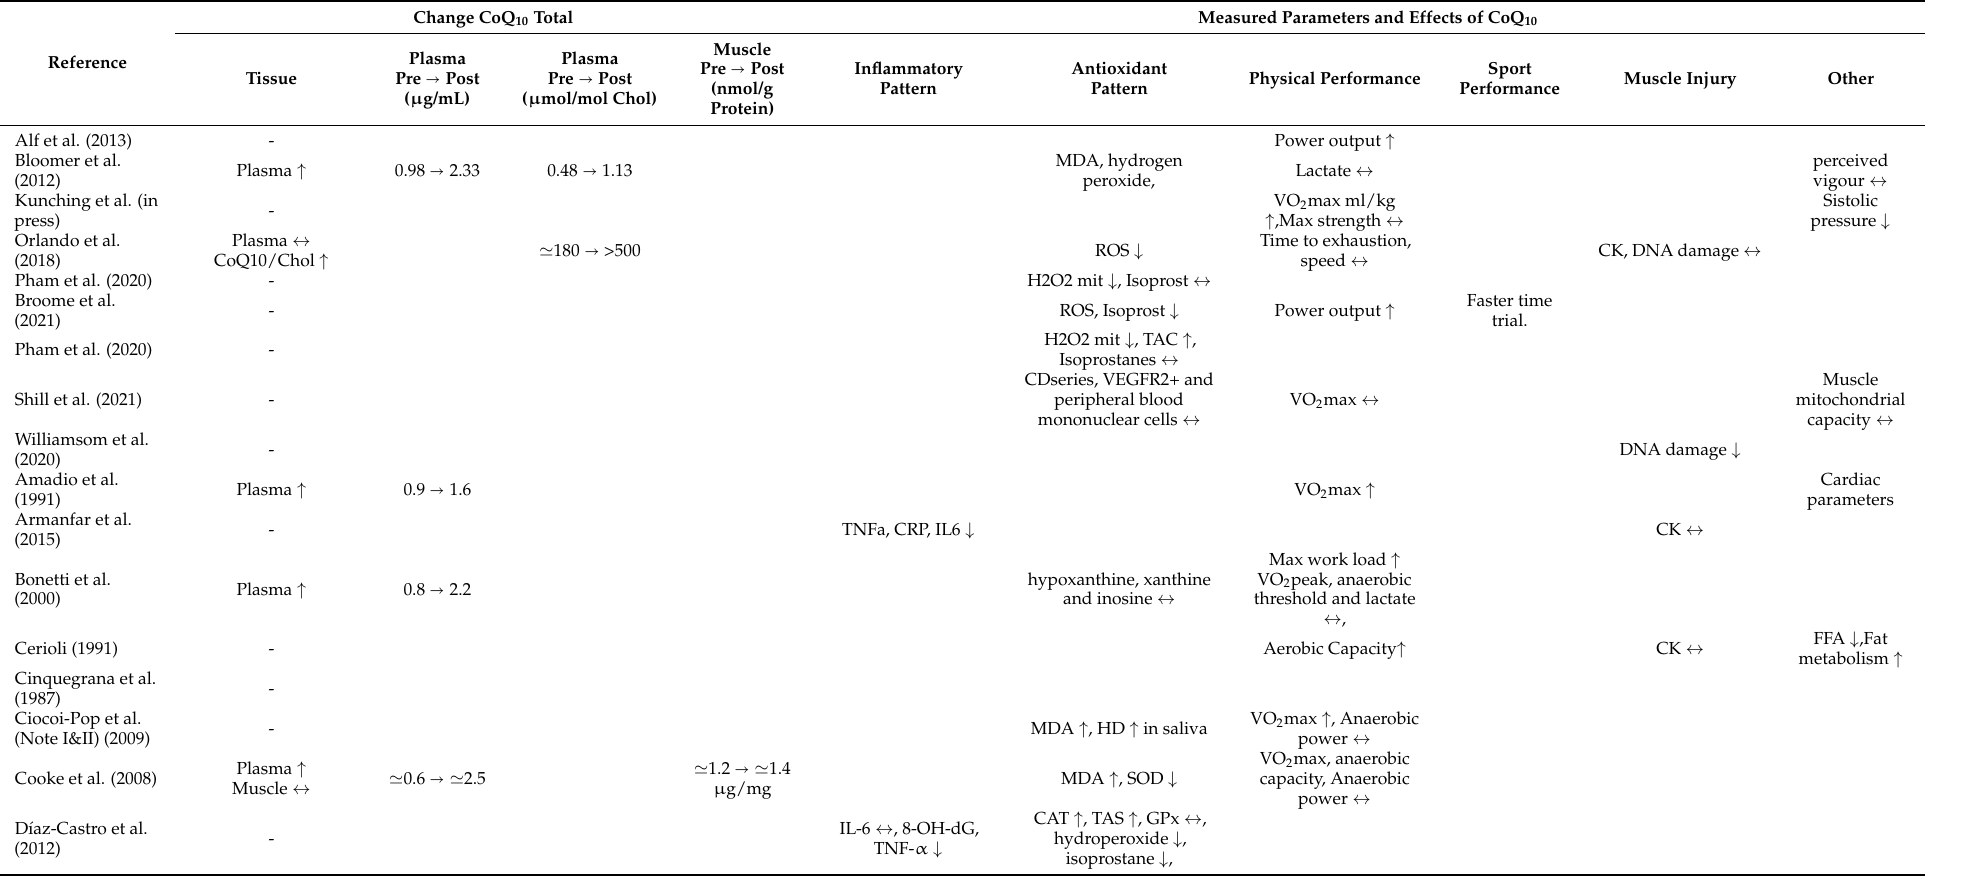
Table 5. Studies without the inclusion